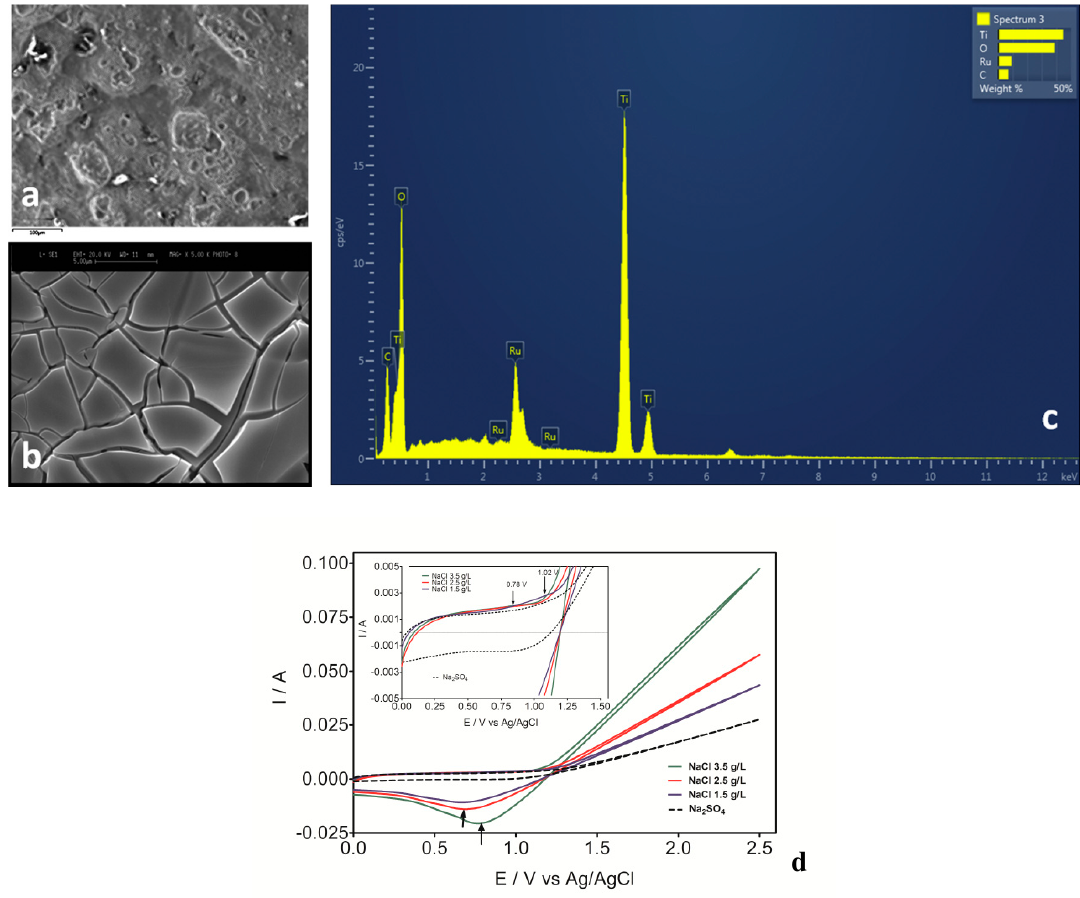
Figure 5. ( a , b ) SEM images; ( c ) EDS; ( d ) Linear scan voltammetry, of Ti / Ru 0.7 Ti 0.3 O 2 electrode synthesized by thermal decomposition. Reprinted with the permission of [91].